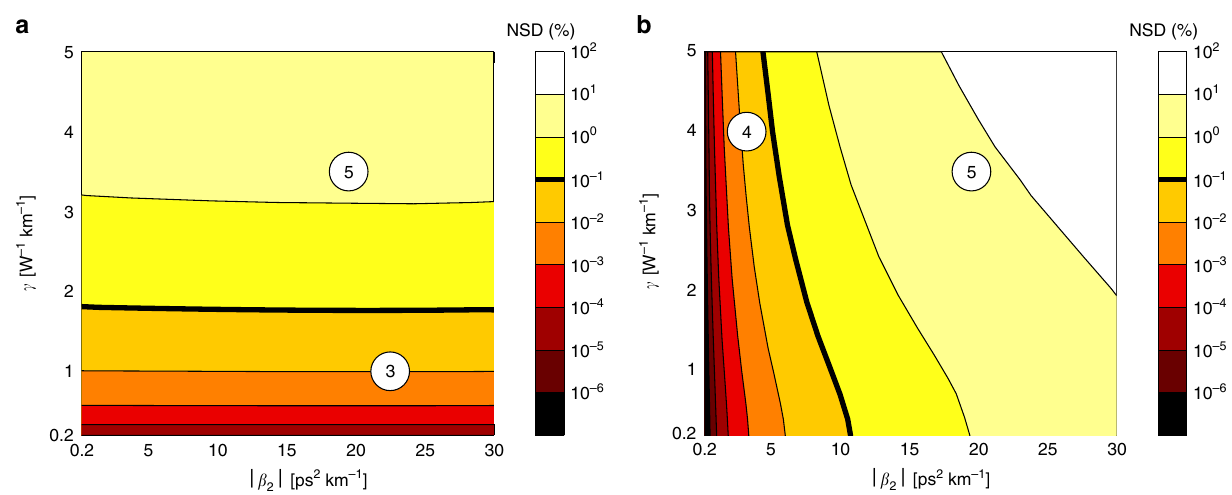
Fig. 5 NSD for the RP on γ and the RP on β 2 for different values of ∣ β 2 ∣ and γ . The system consists of an 80 km fi bre with fi xed input power 5 dBm, symbol rate of 10 Gbaud, α = 0.2 dB km − 1 , and negative β 2 . a Regular Perturbation on γ . b Regular Perturbation on β 2 . Region ③ represents low γ and large ∣ β 2 ∣ values (see Fig. 1). Region ④ represents low ∣ β 2 ∣ and large γ values. Region ⑤ represents large γ and large ∣ β 2 ∣ values. The thick black line of constant 0.1% NSD is used as a threshold for accuracy comparison. The results indicate, as expected, that RP on γ is accurate for region ③ and RP on β 2 is accurate for region ④ . Both models yield low accuracy in region ⑤ shows the NSD for the RP on γ for different values of ∣ β 2 ∣